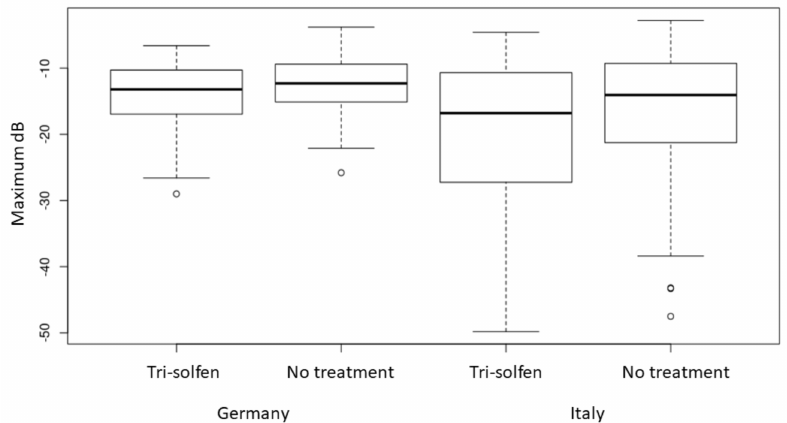
Figure 2. Box plot of peak vocal responses (peak dB) by treatment group and site. (Note, peak dB is recorded on a negative logarithmic scale where 0 is the maximum response). White circles are outliers.